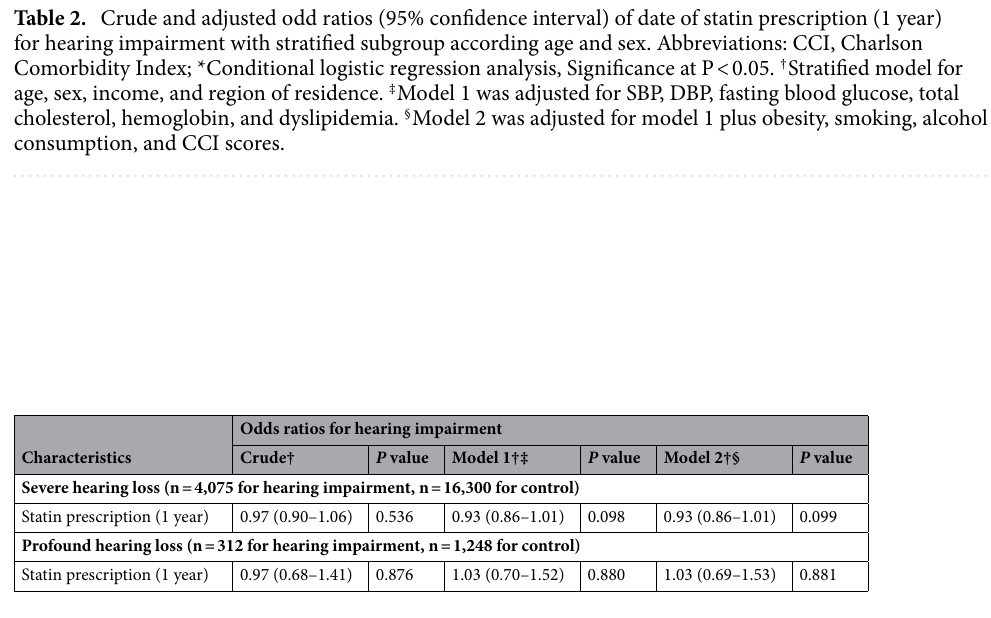
Table 3. Crude and adjusted odd ratios (95% confidence interval) of date of statin prescription (1 year) for hearing impairment by severity of hearing impairment. Abbreviations: CCI, Charlson Comorbidity Index; *Conditional logistic regression analysis, Significance at P < 0.05. † Stratified model for age, sex, income, and region of residence. ‡ Model 1 was adjusted for systolic blood pressure, diastolic blood pressure, fasting blood glucose, total cholesterol, hemoglobin, and dyslipidemia. § Model 2 was adjusted for model 1 plus obesity, smoking, alcohol consumption, and CCI